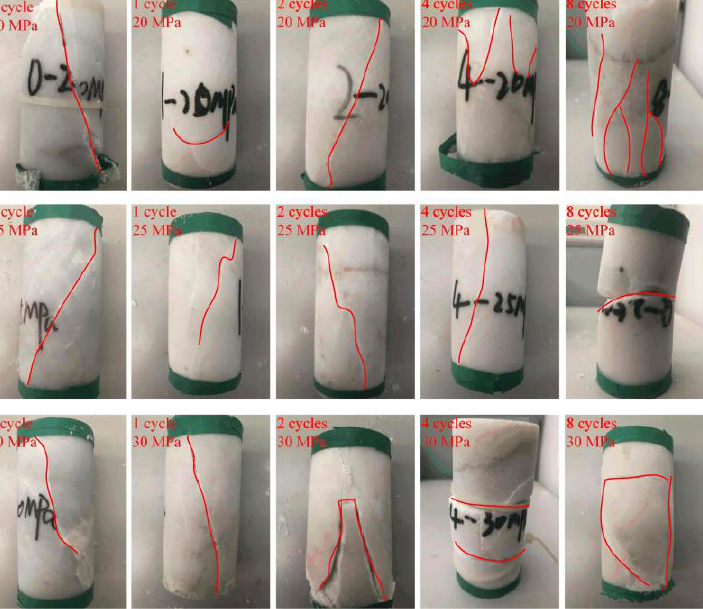
Figure 11. Fracture modes of marble under different confining pressures and different thermal cycles.